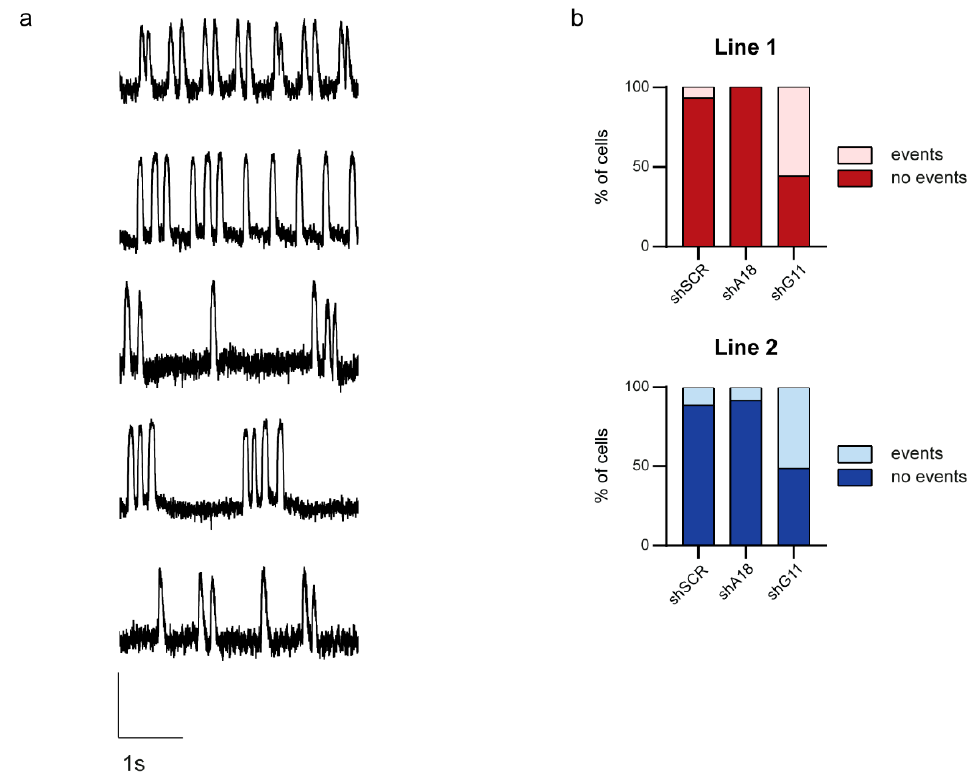
Figure 4. The occurrence of arrhythmic events is affected by allele-specific downregulation of the mutant or wild-type KCNQ1 allele. ( a ) Typical examples of ArcLight traces showing the fluorescence changes over time of hiPSC-CMs with arrhythmic events; ( b ) Percentage of cells with arrhythmic events in hiPSC-CMs of Line 1 in red (top; shSCR: n = 28, 2 with events; shA18: n = 19, no events; shG11: n = 34, 19 with events) and hiPSC-CMs of Line 2 in blue (bottom; shSCR: n = 43, 5 with events; shA18: n = 47, 4 with events; shG11: n = 41, 21 with events).